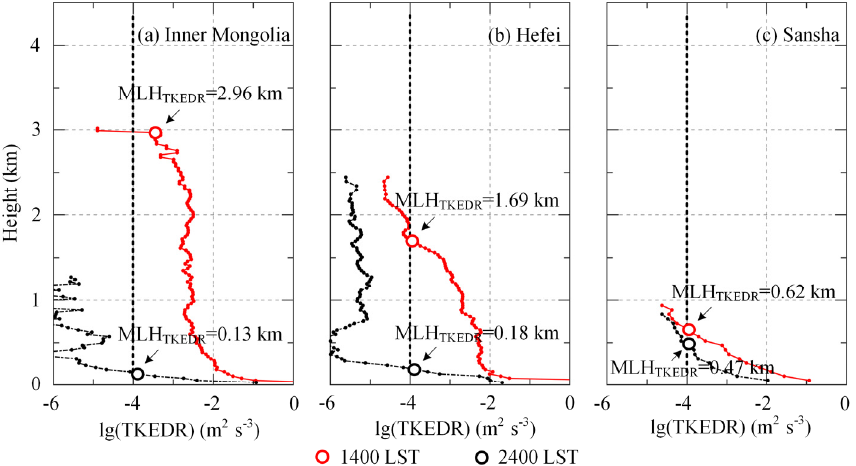
Figure 4. lg(TKEDR) profiles and their MLH TKEDR at 1400 LST (red circle) and 2400 LST (black circle) on ( a ) 27 September 2019 in Inner Mongolia, ( b ) 11 May 2019 in Hefei, and ( c ) 10 November 2018 in Sansha.